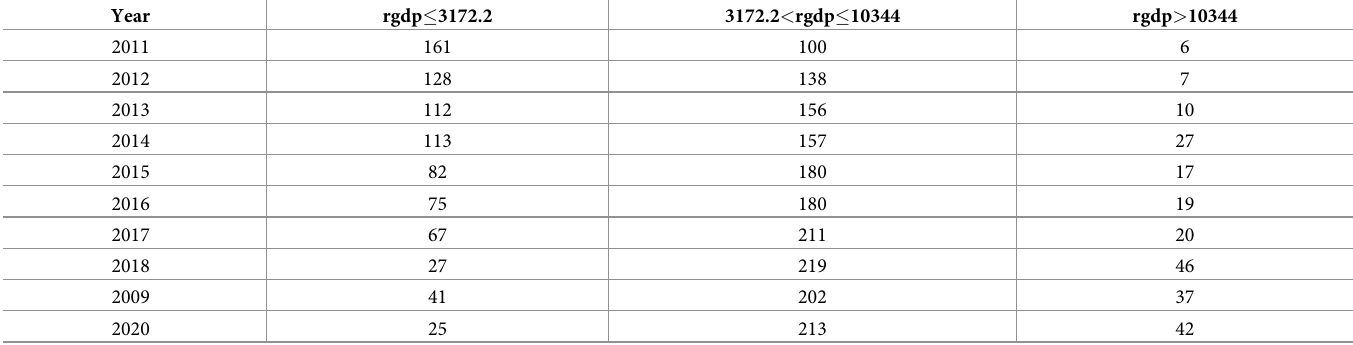
Table 8. 2011–2018 Number of prefecture-level cities by